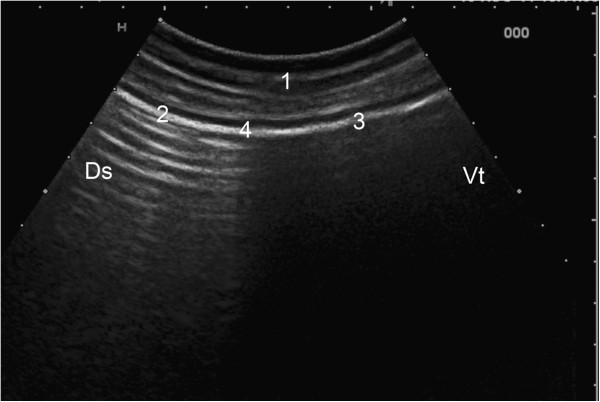
Ultrasonogram of the rumen. Ultrasonogram of the rumen showing the transition between the dorsal gas cap and ingesta layer viewed from the 12th intercostal space on the left side of a nine-year-old Swiss Braunvieh cow. The rumen wall appears as a hyperechoic line. Reverberation artifacts, which run parallel to the ruminal wall, reflect the gas cap and end abruptly at the transition to the fibre mat. 1 Abdominal wall, 2 Rumen wall at the level of the dorsal gas cap, 3 Rumen wall at the level of the fibre mat, 4 Transition between 2 and 3, Ds Dorsal, Vt Ventral.